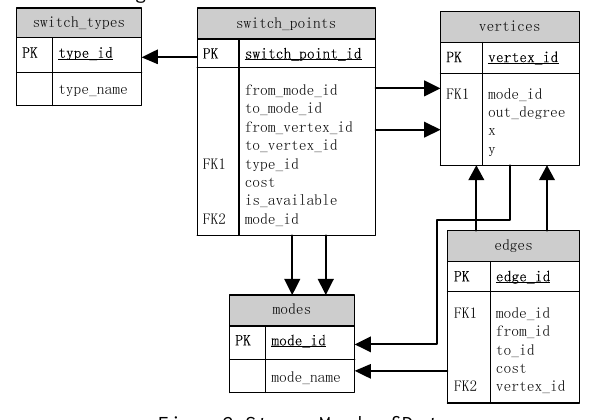
Figure 2. Storage Mode of